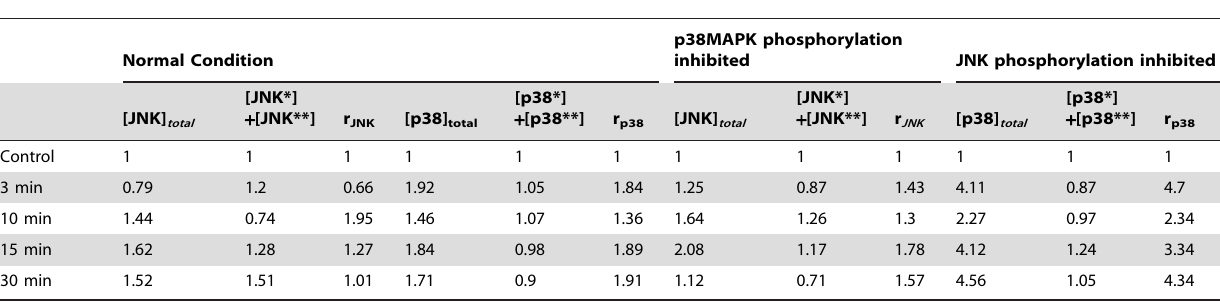
Table 1. Densitometric analysis of western blots for JNK and p38MAPK under normal and perturbed conditions at different time